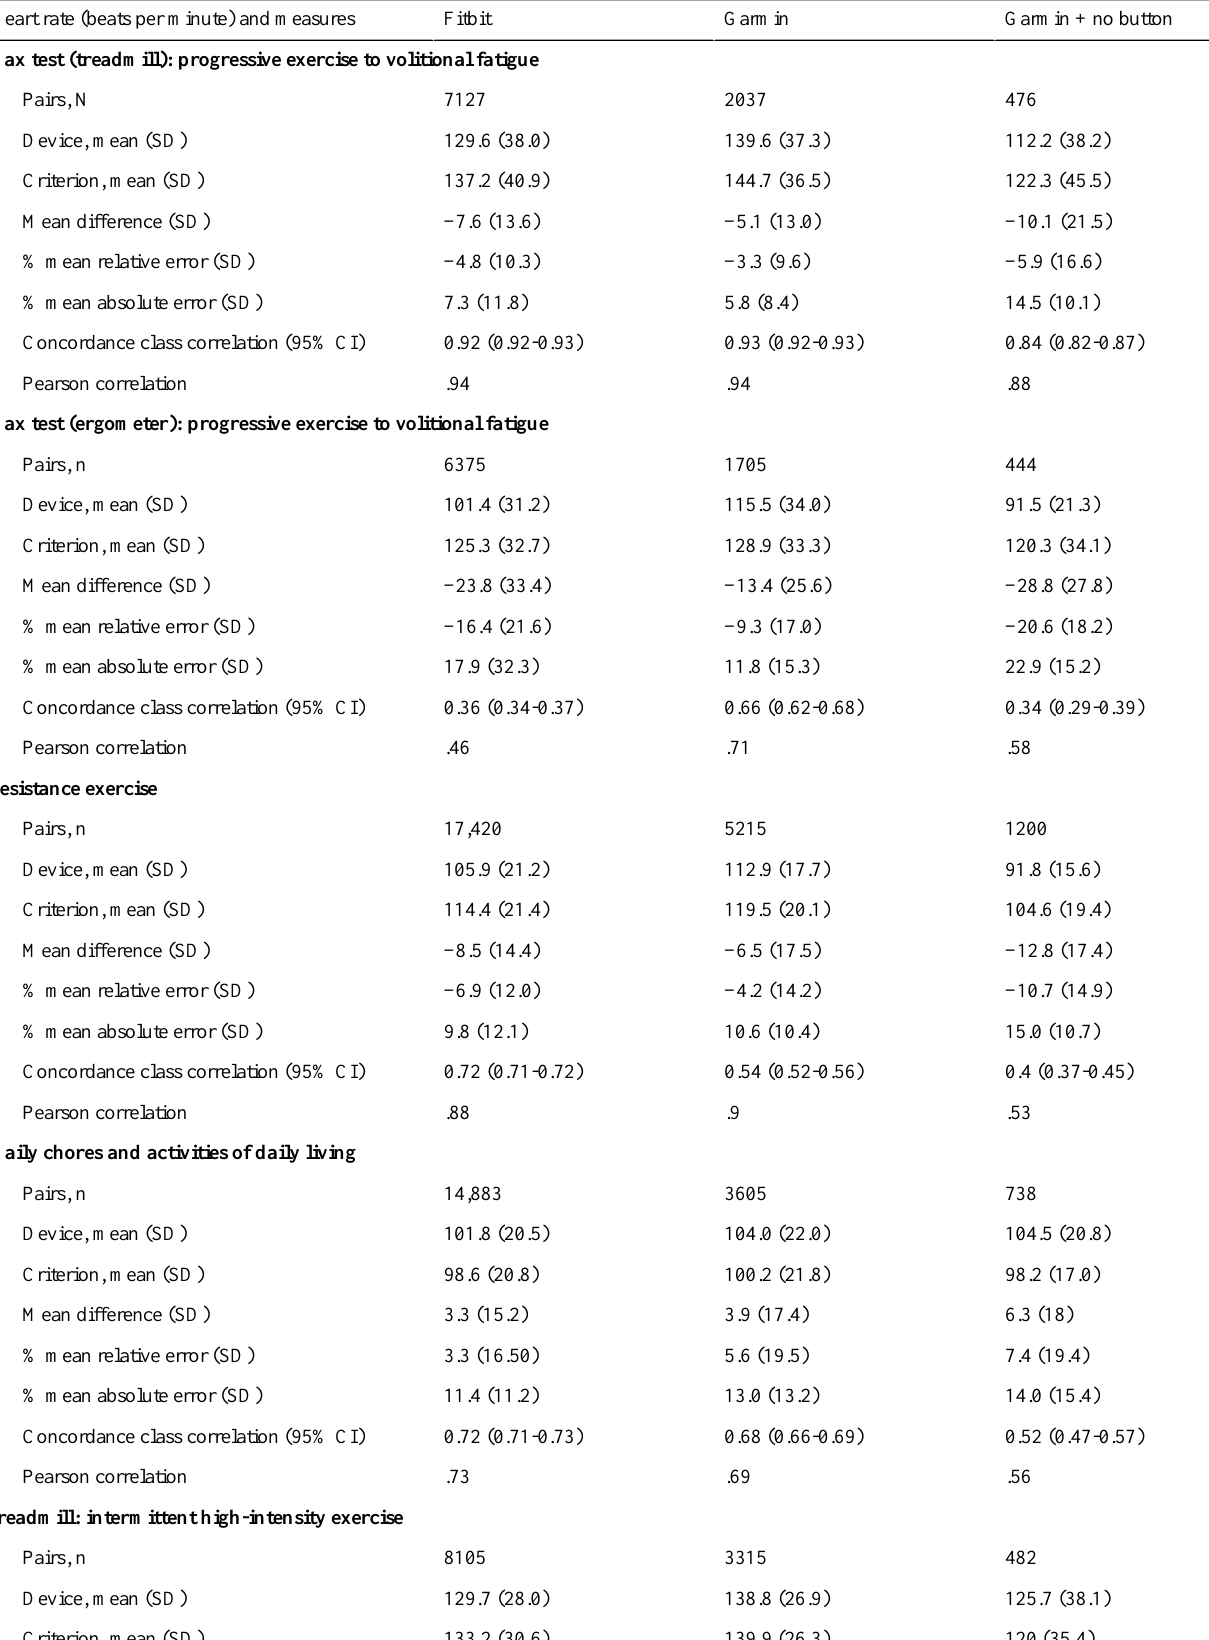
Table 2. Heart rate accuracy data across all subjects for the different activity types undertaken during the study: sample size, mean (SD) of each of the measured devices, mean (SD) of the difference between the device measurement and the reference standard, the mean relative difference (SD; %), the mean absolute difference (SD; %), and the correlation between the